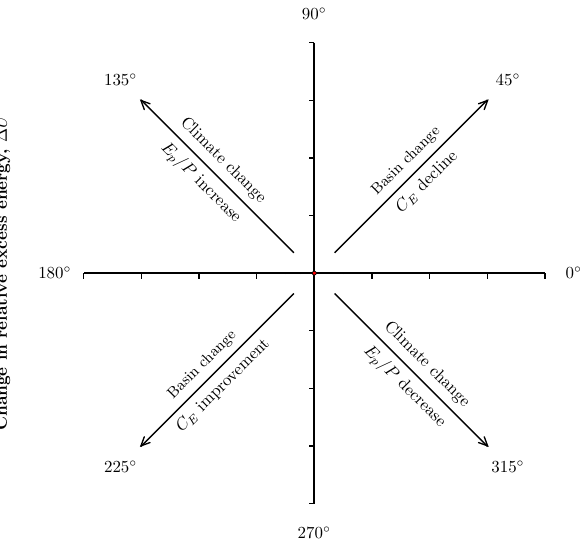
Fig. 1. Illustration of the change attribution framework established by Tomer and Schilling (2009, after their Fig. 2). Considering cli- matic change effects, a change in either precipitation or potential evapotranspiration, will result in a change of both, relative excess water and energy but in opposite direction (change along the neg- ative diagonal). Basin change effects, such as a change in vegeta- tion or soils may lead to a change in evapotranspiration and thus in catchment efficiency ( C E , Eq. 8), which results in a deviation from the negative